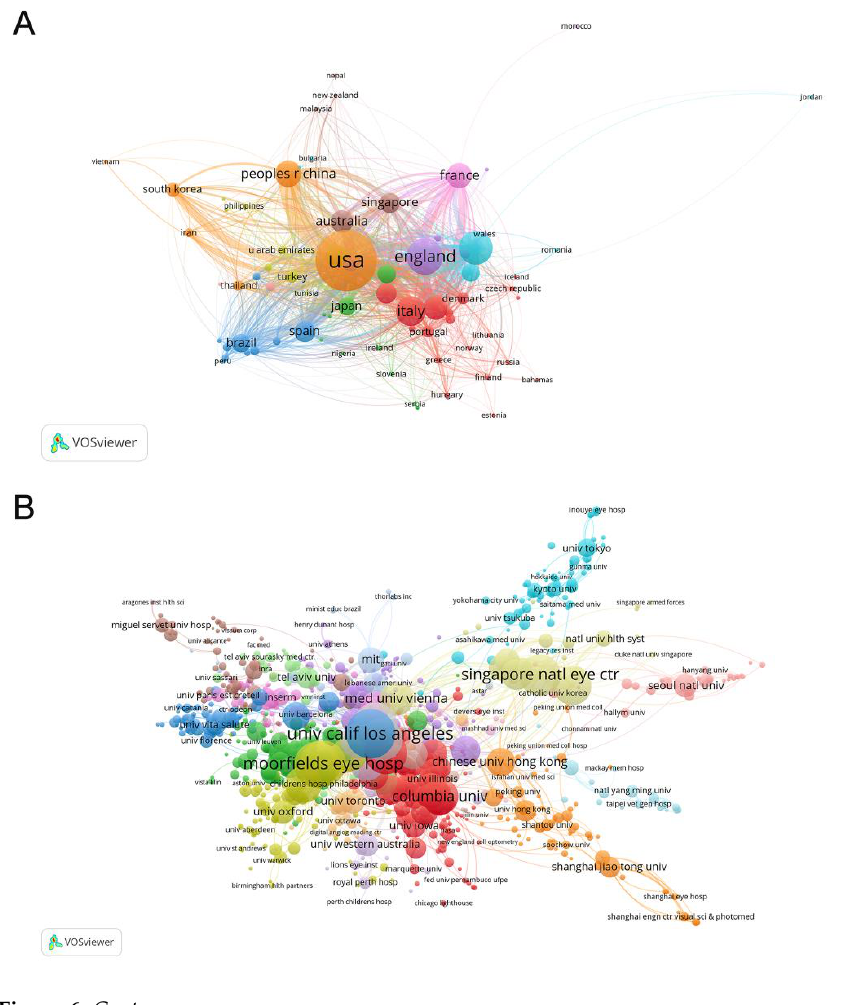
Figure 6. Analysis of Co-authorship relationship. ( A ) Collaboration network of countries/regions; ( B ) Collaboration network of institutions; ( C ) Collaboration network of authors. 3.5. Contribution of Journals Table 5 shows the top 10 productive and co-cited journals. Investigative Ophthalmol- ogy and Visual Science obtained the most publications (2026), followed by Retina-The Journal of Retinal and Vitreous Diseases (1994) and American Journal of Ophthalmology